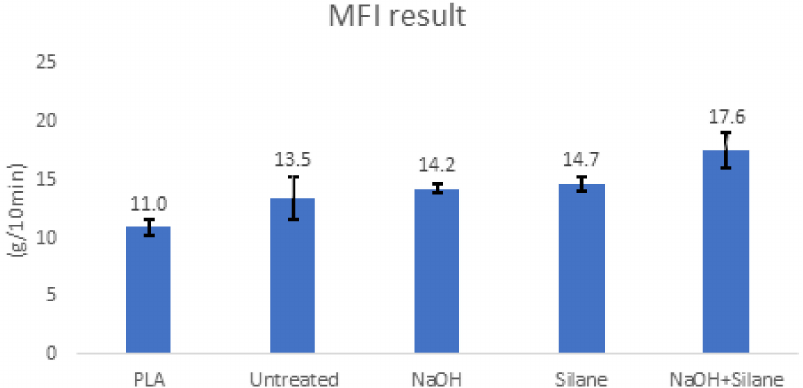
Figure 7. The 2.5% SPF/PLA composite MFI